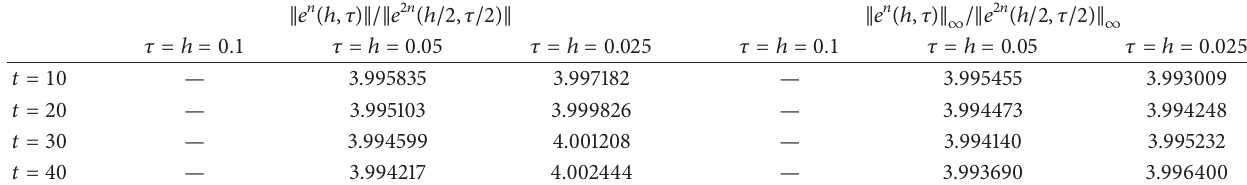
Table 4: The verification of the second convergence of Scheme II.